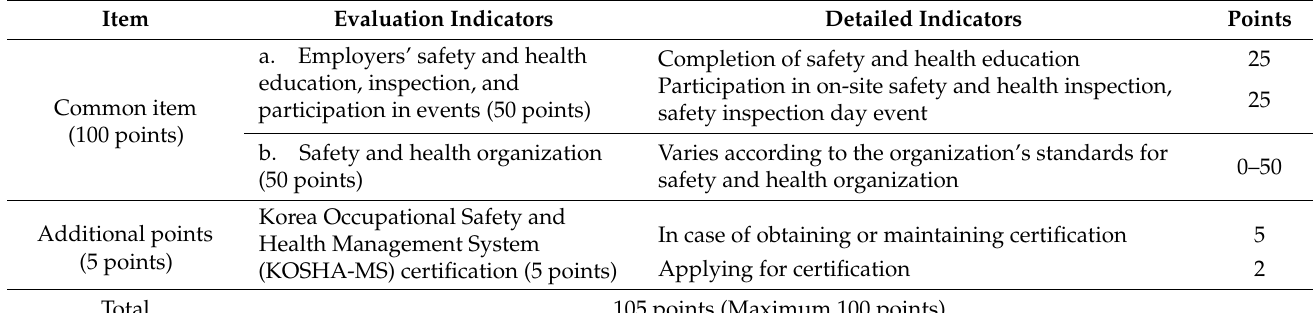
Table 3. Construction companies without construction sites where are obligated to appoint a safety and health manager (Type B).